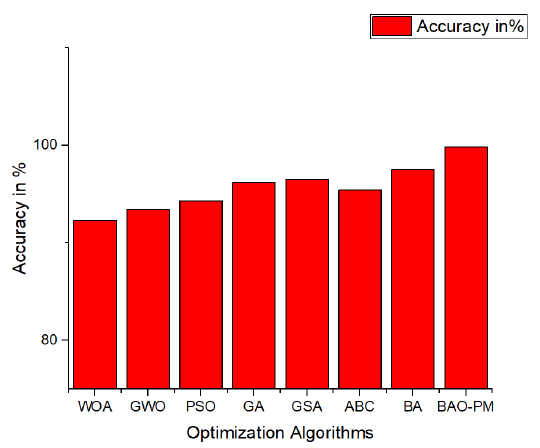
Figure 15. Accuracy achieved by BAO with PM operator.